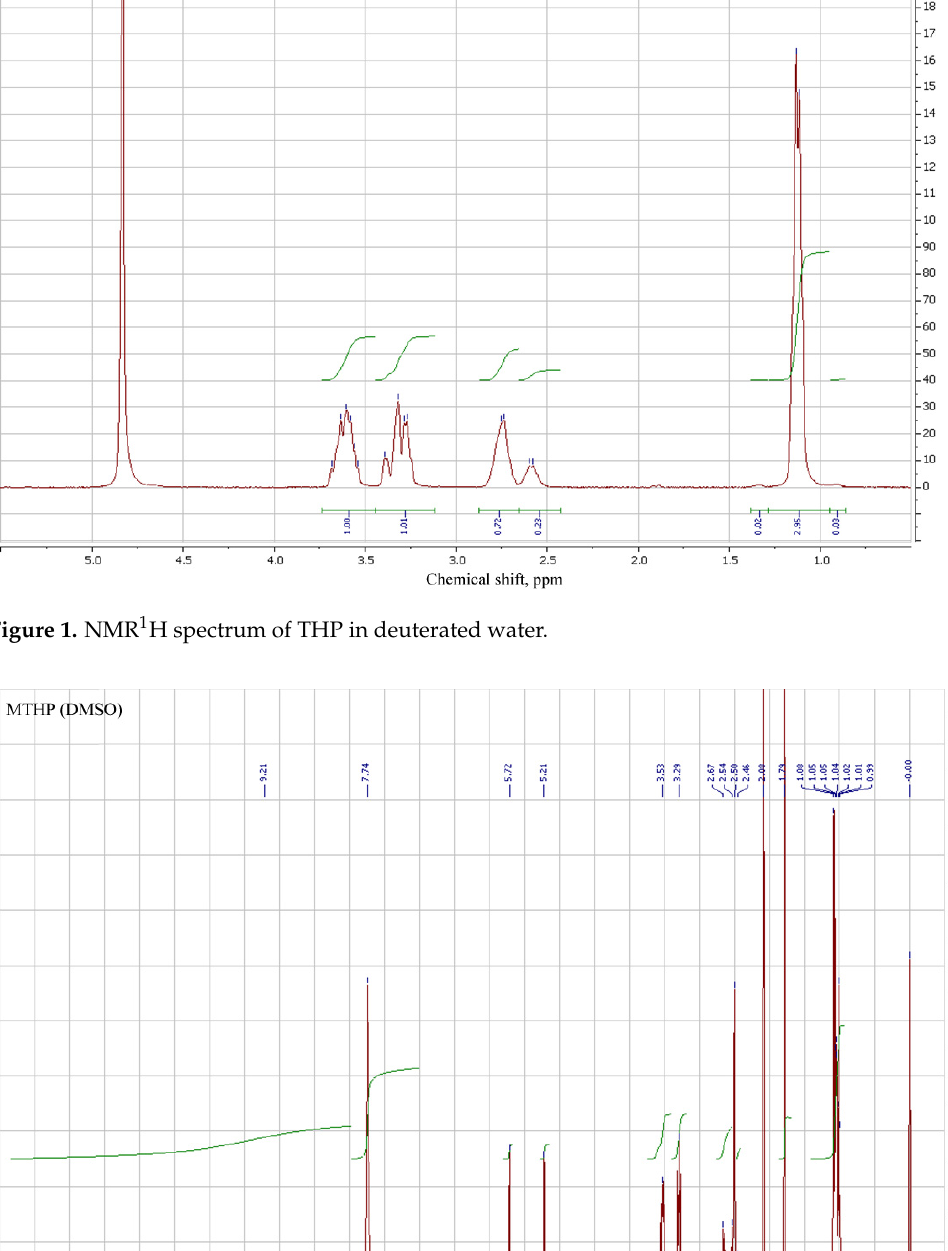
Figure 3. NMR 1 H spectrum of MTHP acetone-soluble fraction in deuterated DMSO. 3.3. The Possibility of MTHP (Co)Polymerization MTHP (co)polymerization is a way to include the cyclical byproduct in polymeriza- tion via creating the salt of THP and MA at an equimolar ratio (Scheme 4), in aqueous media, as all the reagents are water-soluble. Polymerization results are comparable with MAG in [2], yield 60–75%.